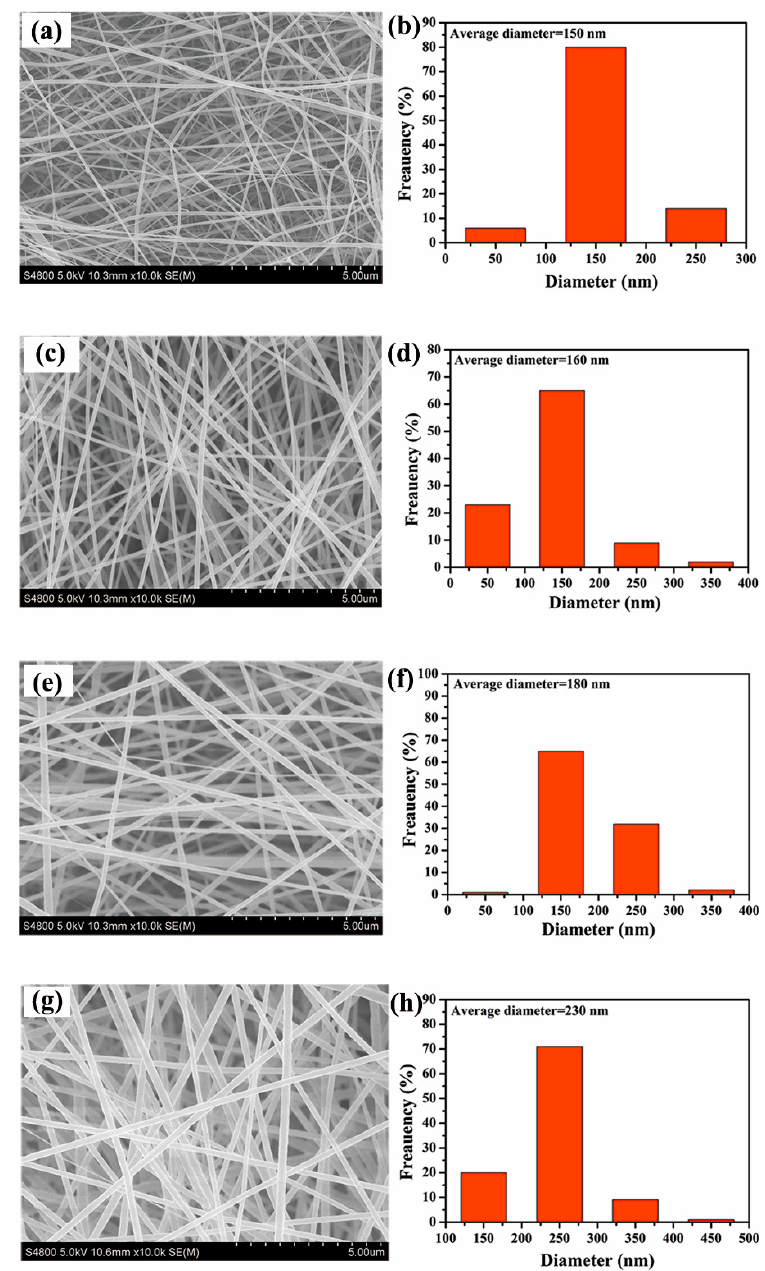
Figure 1. SEM images and diameter distributions of: ( a , b ) PAN nanofibers; ( c , d ) PAN–TA-1 nanofibers; ( e , f ) PAN–TA-3 nanofibers and ( g , h ) PAN–TA-5 nanofibers.